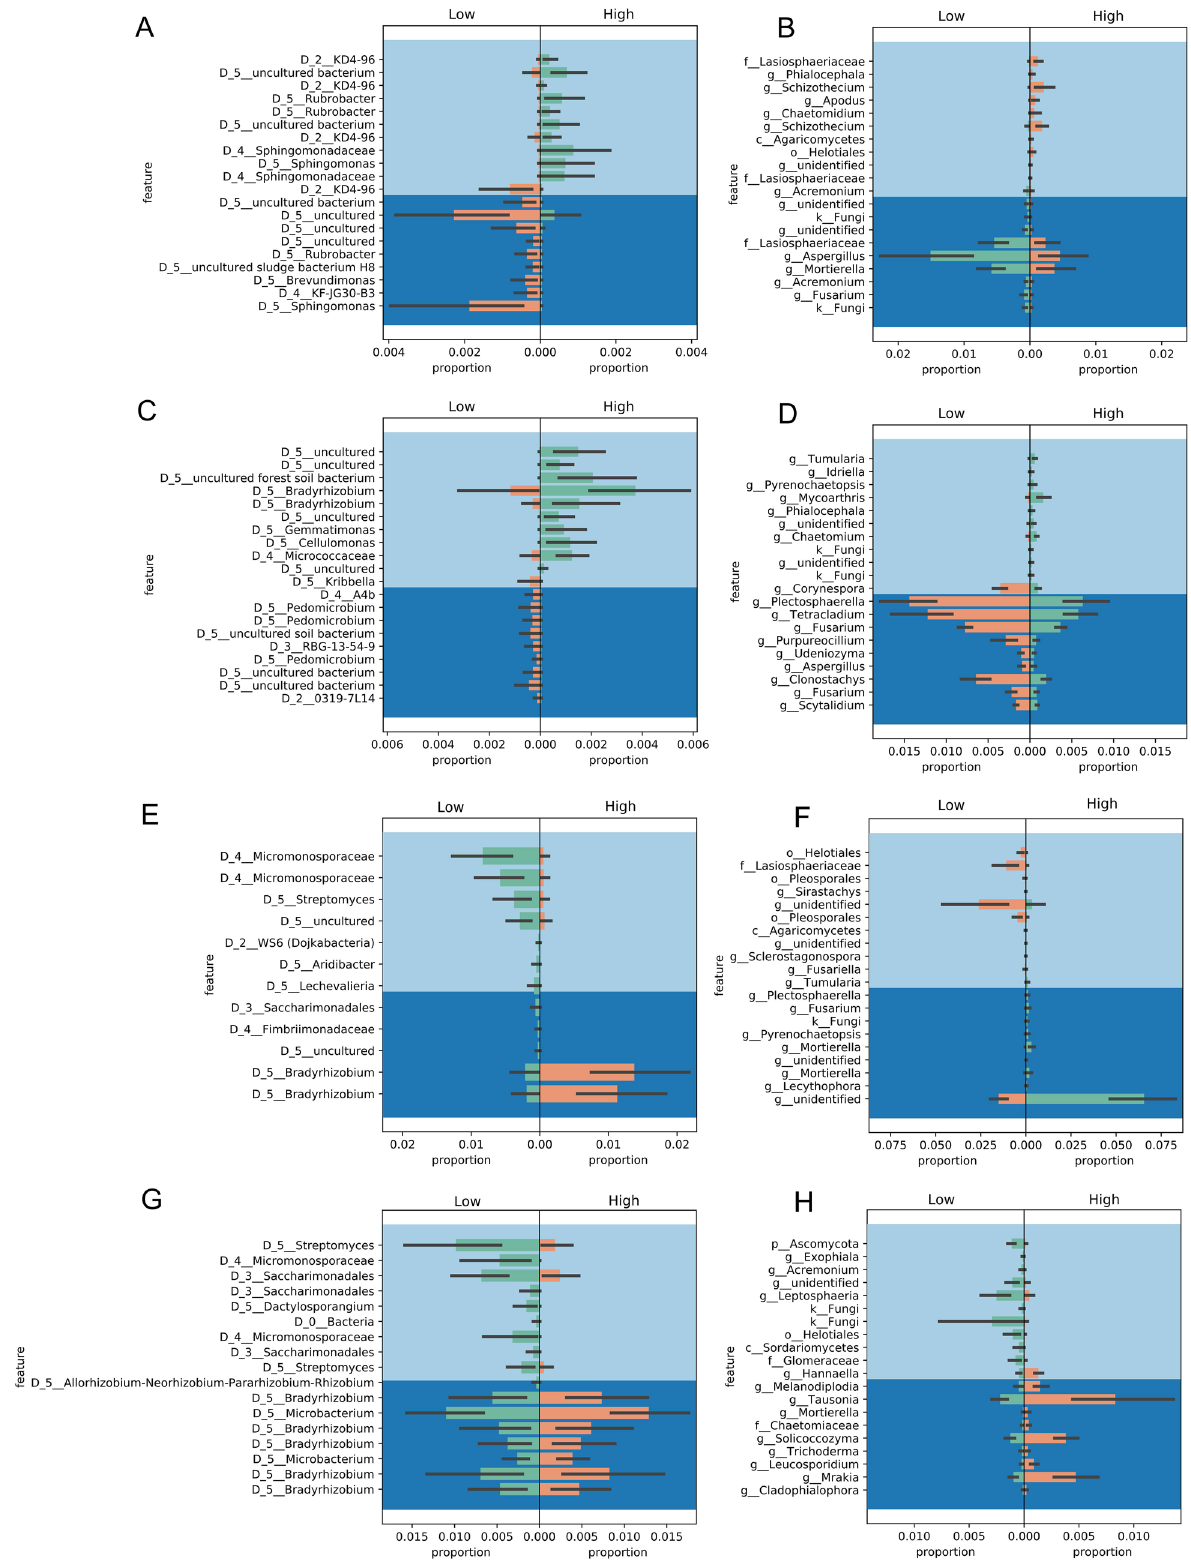
Figure 2. Differential abundance of taxa analyzed by Gneiss approach. Abundances of bacterial ( A ) and fungal ( B ) population at the Monmouth site, and bacterial ( C ) and fungal ( D ) population at the Urbana site associated with bulk soil; bacterial ( E ) and fungal ( F ) population at the Monmouth site, and bacterial ( G ) and fungal ( H ) population at the Urbana site associated with roots are shown. The differential abundance analysis was performed based on high- and low-yield groups. The high yield group is CCC (continuous corn) and SCC (two years corn). The low yield group is CSC (one year corn) and SCS (one year soybean). Figure was created using built-in function in 85